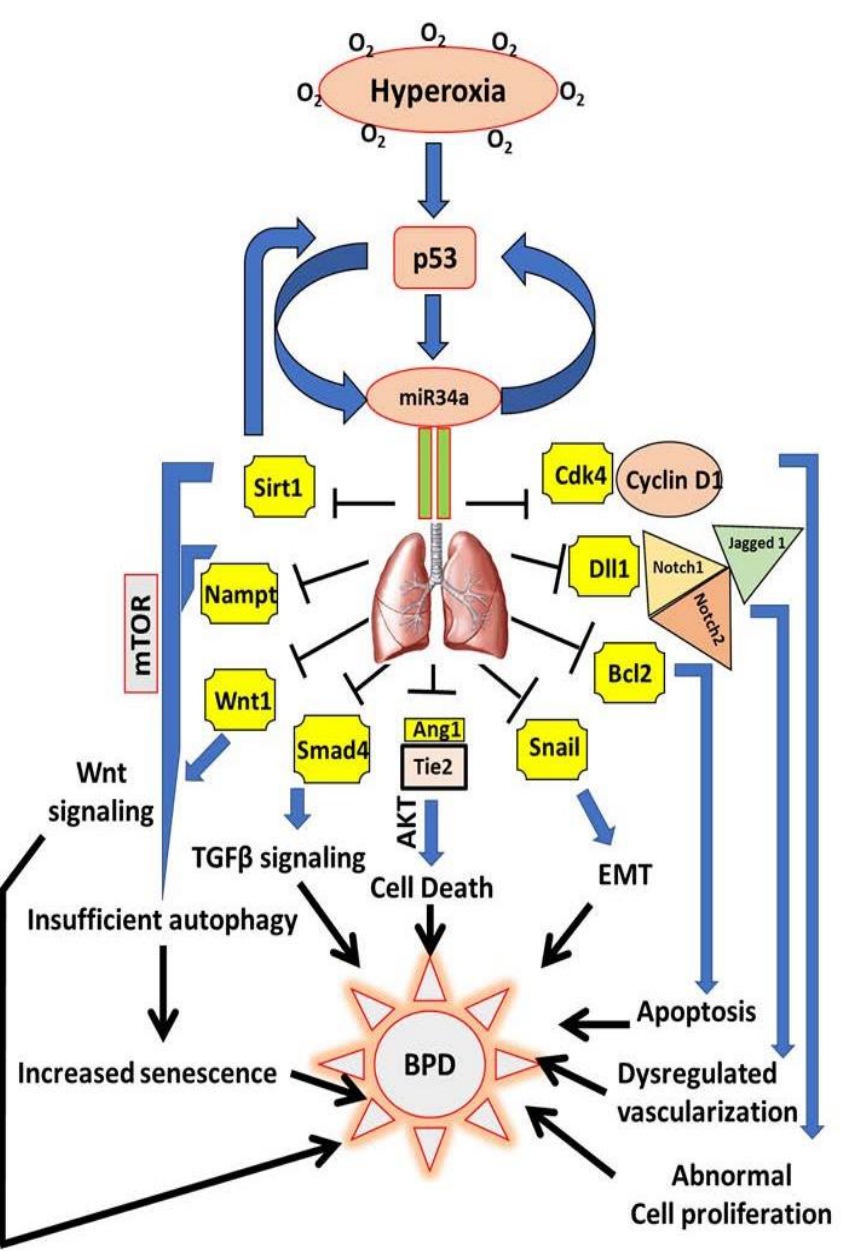
FIGURE 1: miR34a as a master regu- lator of the proposed cell signaling pathways involved in the patho- genesis of BPD . Hyperoxia